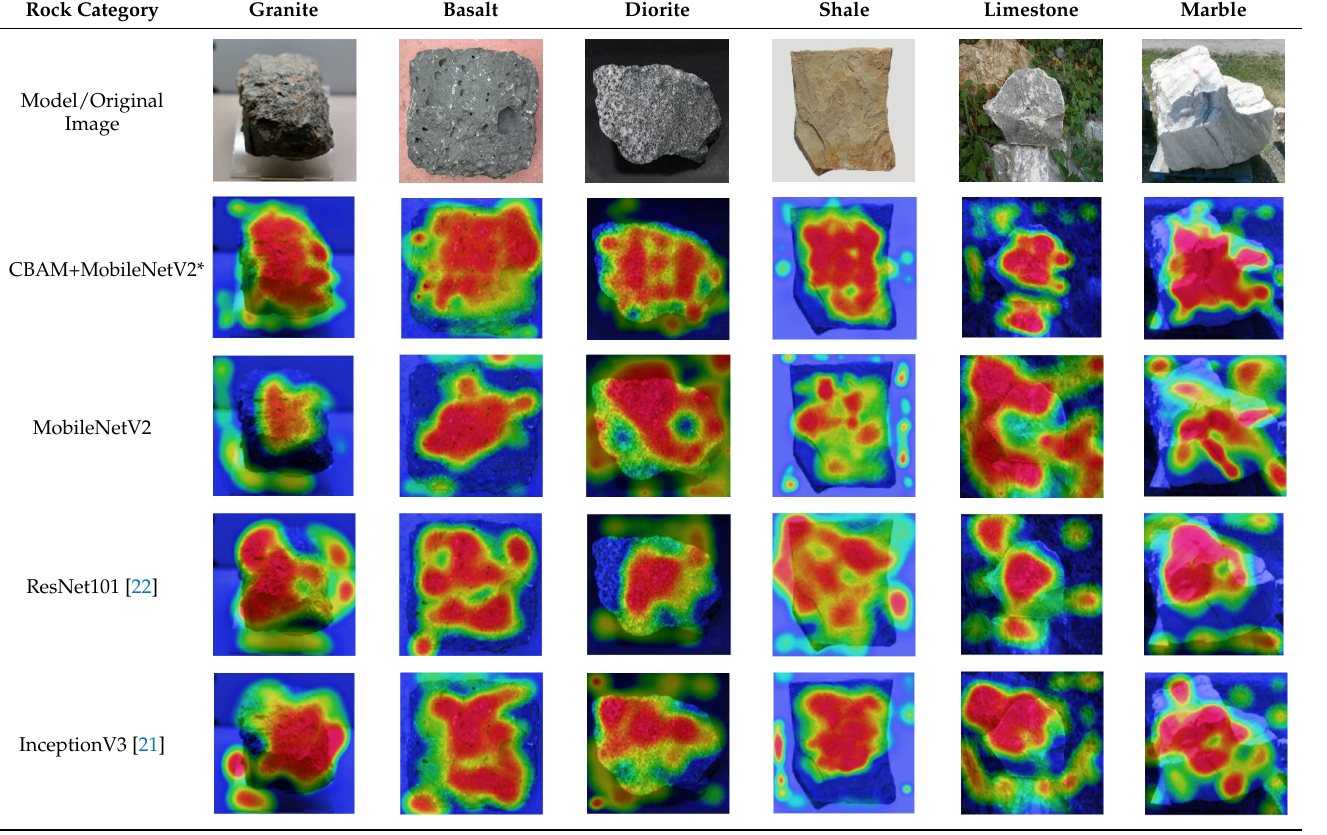
Table 6. Grad-CAM interpretability analysis.